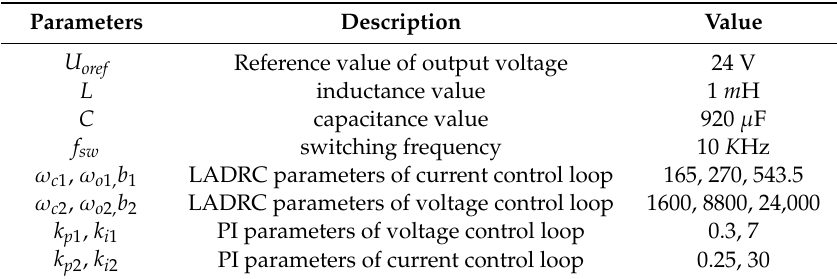
Table 1. Simulation parameters.